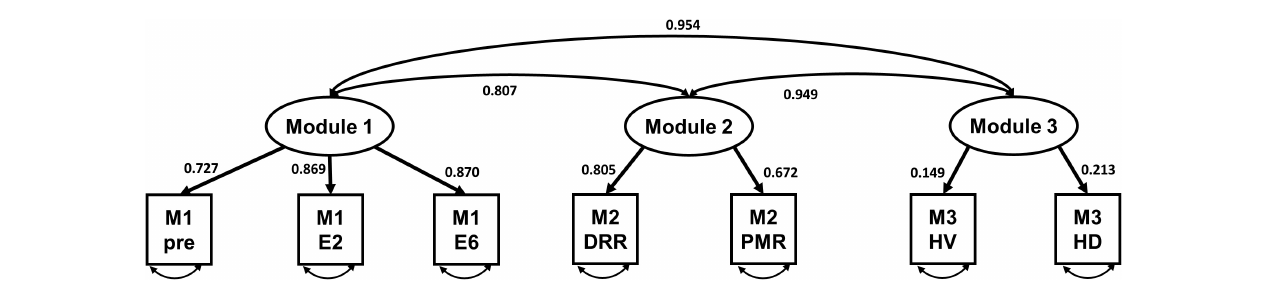
measures. There was also a strong association between AS, HADS-D, and